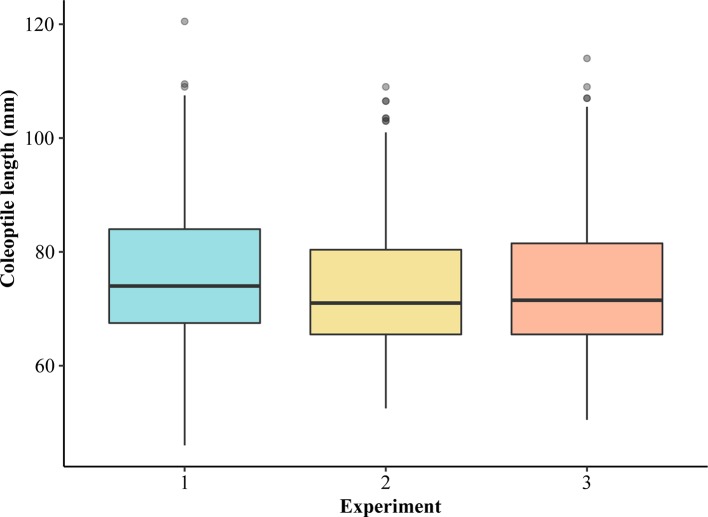
Boxplots showing the distribution of average coleoptile length of 298 genotypes of hard winter wheat association mapping panel (HWWAMP) in three experiments.